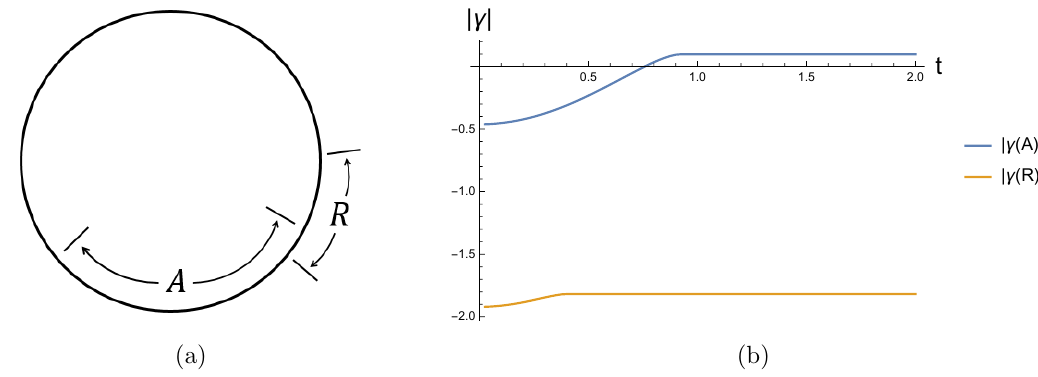
Figure 11. (a) Choice of the regions A and R . (b) Lengths of the HRT surfaces j (cid:13) ( A ) j and j (cid:13) ( R ) j as functions of time.